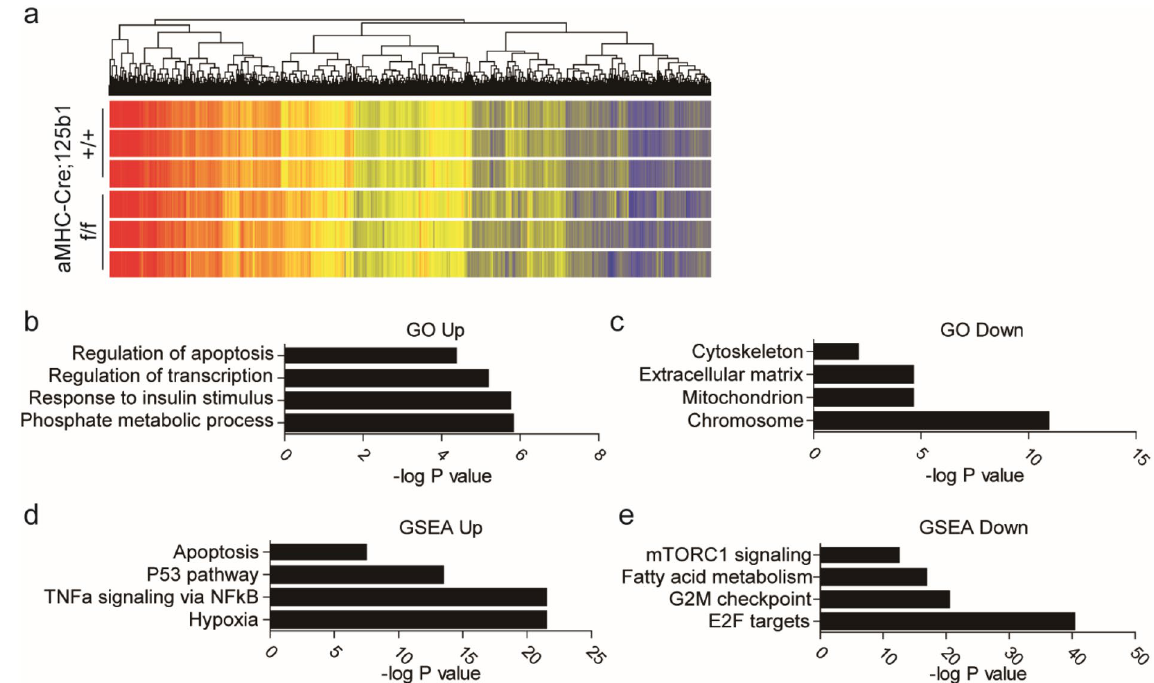
Figure 5. Altered transcriptome in miR-125b deficiency mice. ( a ) Heatmap of microarray. ( b ) Gene ontology of upregulation genes in the knockout neonates. ( c ) Gene ontology of downregulation genes in the knockout neonates. ( d ) Gene set enrichment assay (GSEA) with the Hallmark gene set in the upregulation genes. ( e ) Gene set enrichment assay (GSEA) with the Hallmark gene set in the downregulation